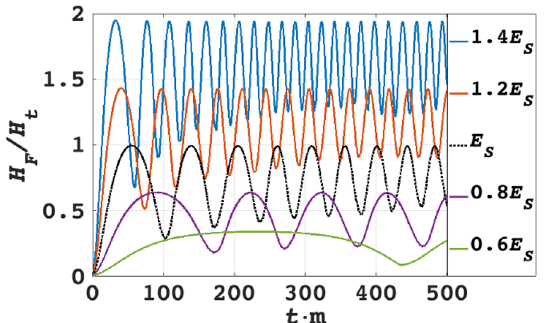
Figure 8 . Numerical evolution of fermion Hamiltonians (normalized by total Hamiltonian with background electric field E S ) with different background gauge field strengths. The lower envelopes of these Hamiltonian curves can be used as an indicator of the pair production rate. It shows that when the background electric field approaches 0.5 E S , the Schwinger effect becomes negligible. With a background electric field stronger than E S , the pair plasmas can be quickly generated and then saturated by the nonlinear radiation backreaction in a relatively short period. ( e/m = 0 . 2 , ∆ x i = 0 . 05 /m, ∆ t = 0 . 5∆ x i , N t = 2 × 10 4 , N x = N y = 1 , N z = 256 , N e = 512